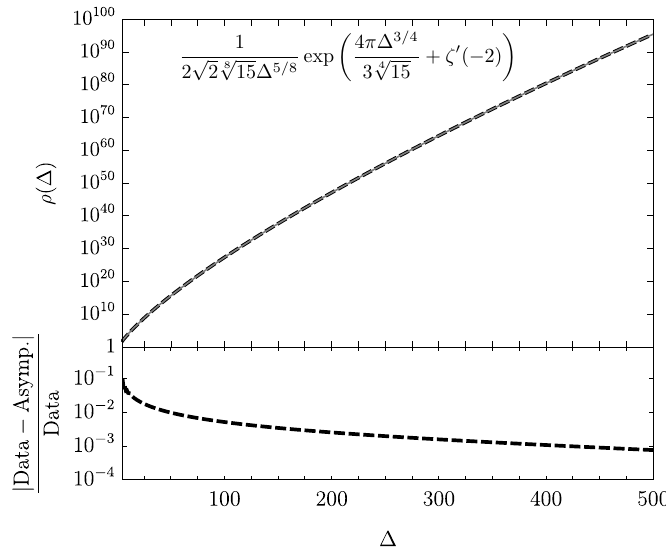
Figure 1: The growth of operators for a single real scalar in d = 4. Upper panel: The thick dashed line corresponds to exact data, obtained by a direct expansion of the PE. The thin grey curve that is indistinguishable from the data in the upper panel is the asymptotic result. Lower panel: Relative error between data and the asymptotic